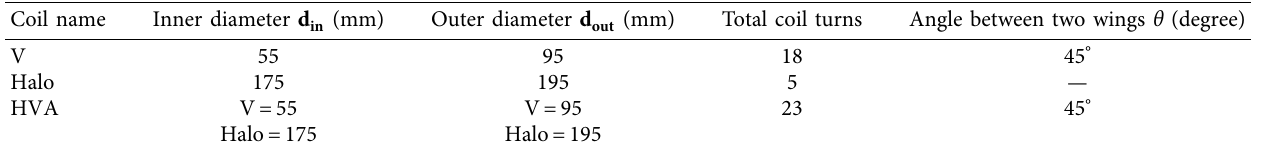
Table 2: Design parameters of three